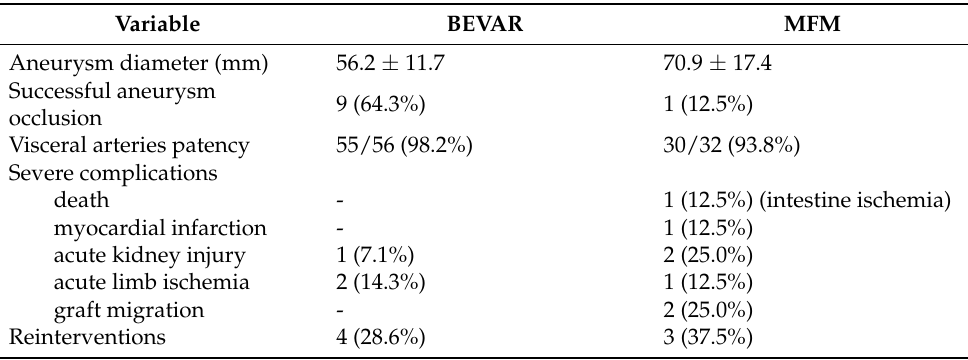
Table 2. Early outcomes (30 days after